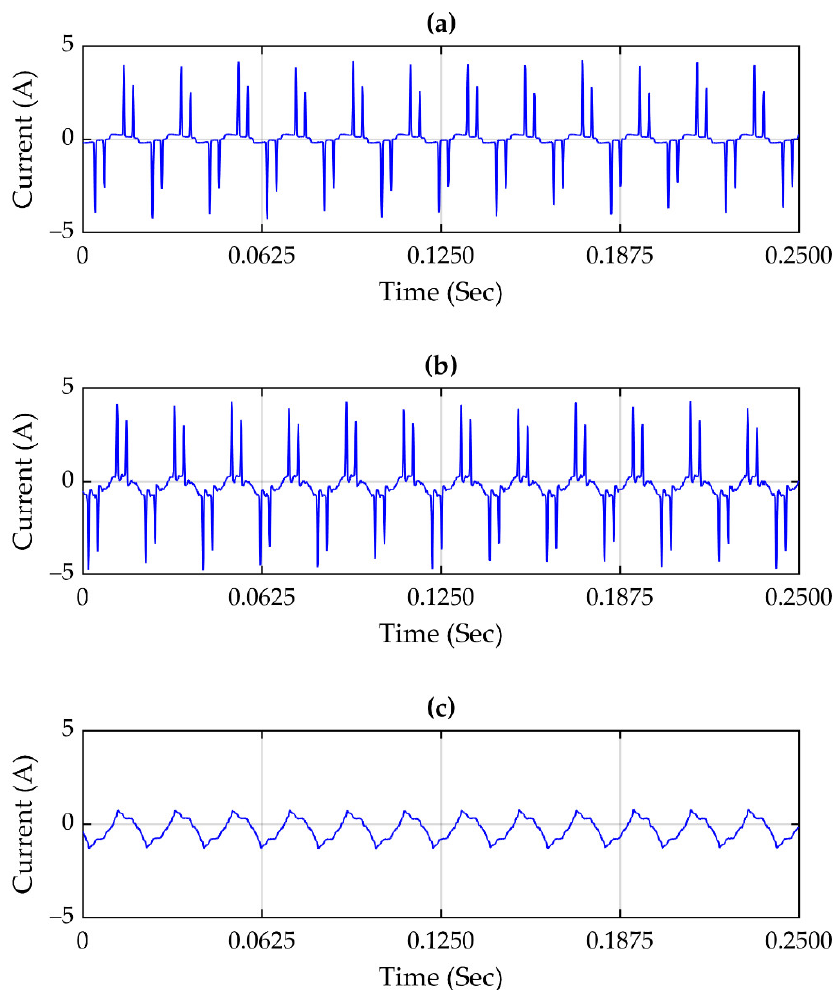
Figure 14. Signals ( a – c ) correspond to GPS synchronized data logger GSD-1, GSD-2, and GSD-3, and the graphics show a harmonic content tracking where it propagated to three sites in the grid.